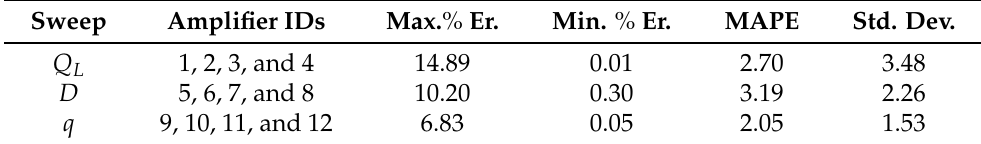
Table 7. Estimation error results.